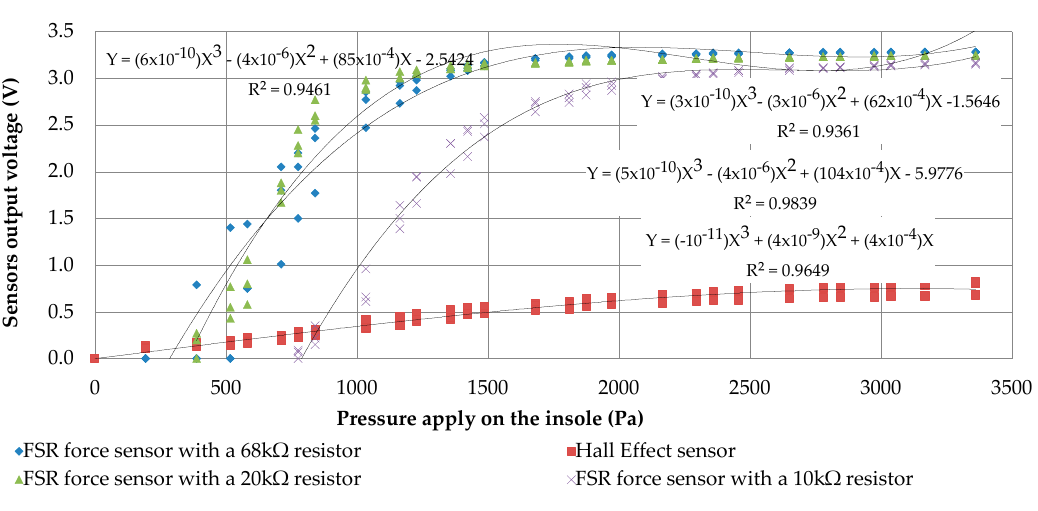
Figure 6. Graphic of force sensors measures with different FSR’s resistor compared to a Hall Effect sensor.